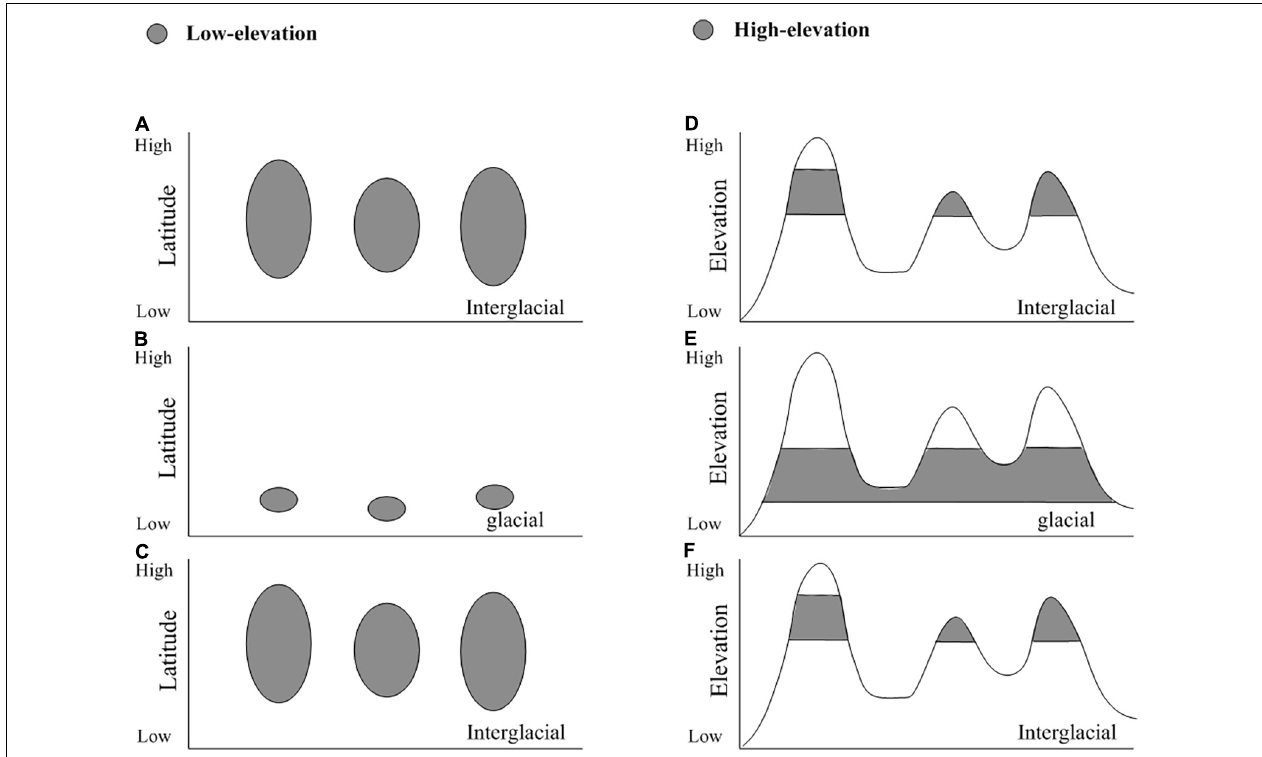
FIGURE 1 | Hypothetical migration of interglacial expansion and glacial expansion during Quaternary. The distribution range of low-elevation and high-elevation species are presented in panels (A–C) and panels (D–F) ,